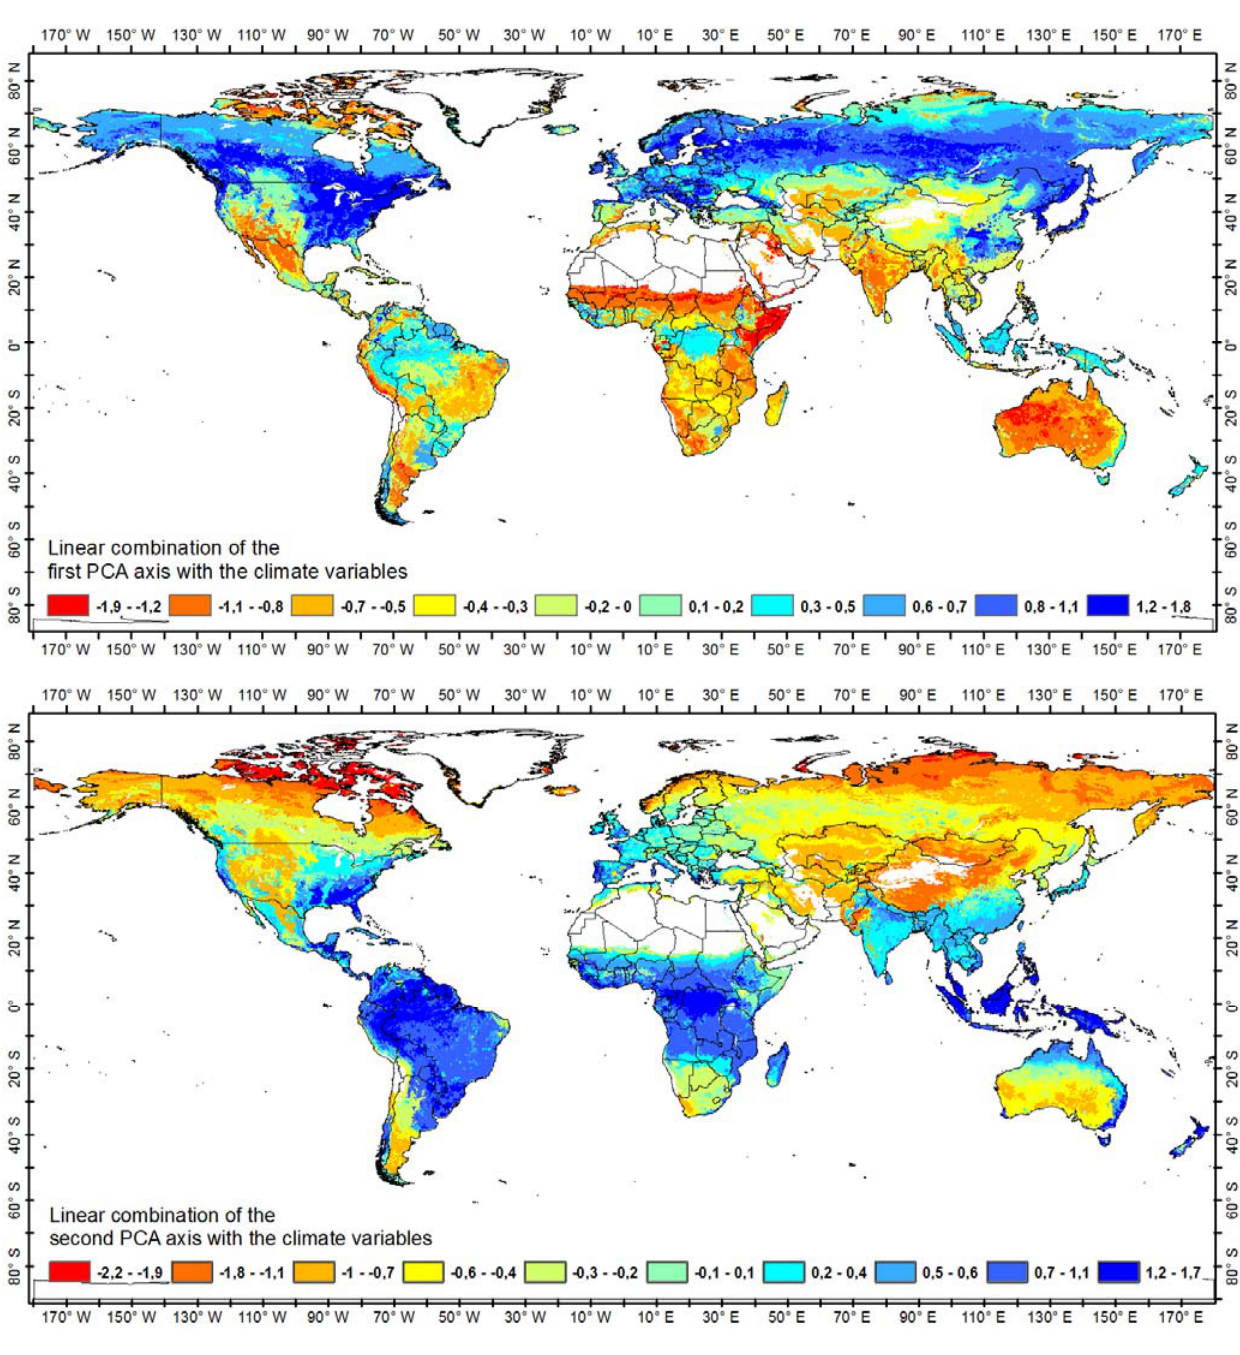
Figure 5. Linear combination of the first ( top ) and second ( bottom ) gradient PCA axes with the variables indicating climatic constraints of vegetation growth. White areas represent pixels without vegetation